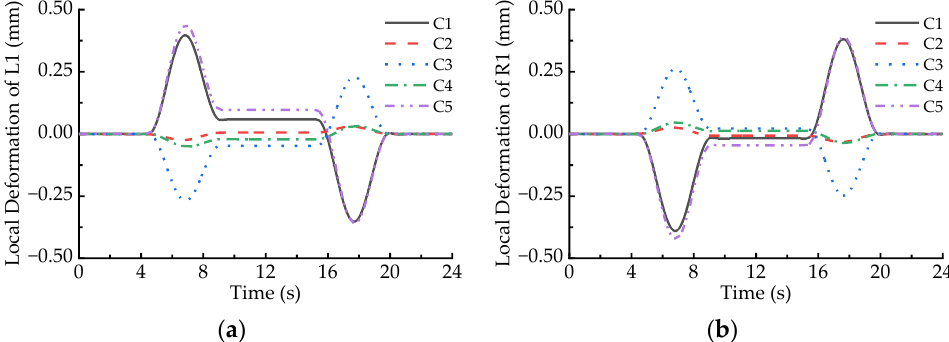
Figure 7. Local deformation of the LMs passing through the 650 m radius curve at the speed of 93 km/h: ( a ) L1; ( b ) R1.